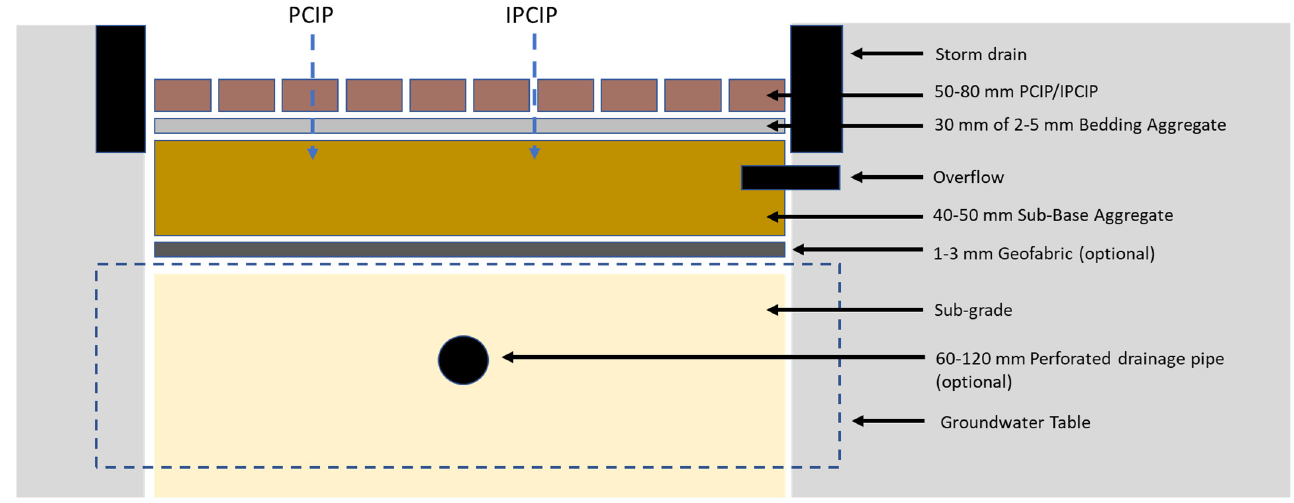
Figure 1. Typical setup of a Dutch infiltrating pavement structure (Adapted with permission from [28]).